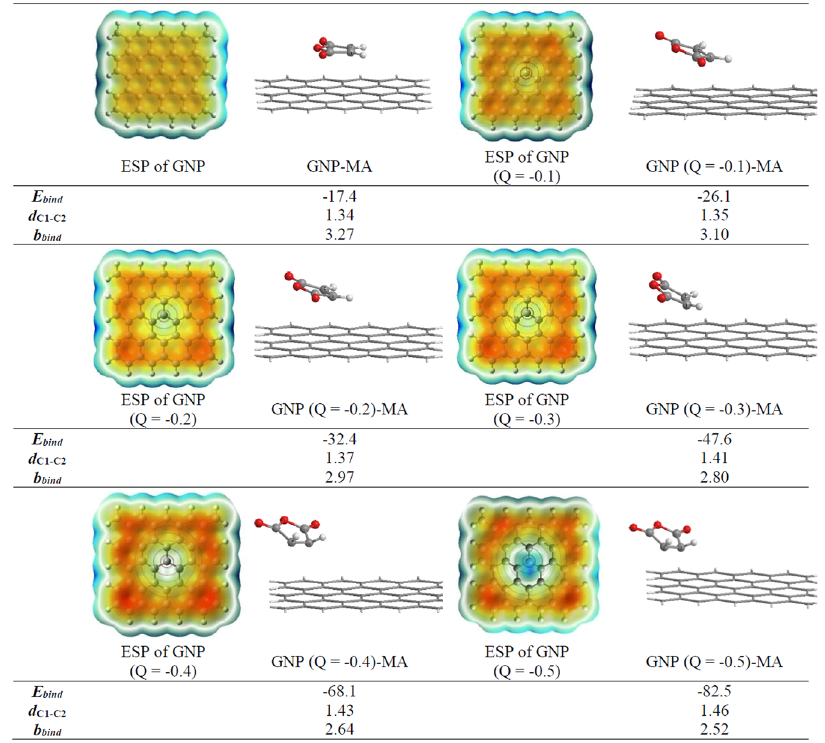
Figure 2. The electrostatic potential surface (ESP) generated at B97-D/6 − 31 + G * level of theory. Red and blue colors signify the regions with charge accumulation and depletion, respectively. Counterpoise corrected binding energies ( E bind ) in kcal/mol, C-C bond lengths ( d C1-C2 ) and binding distances ( b bind ) in Å, for the studied GNP- maleic anhydride (MA)